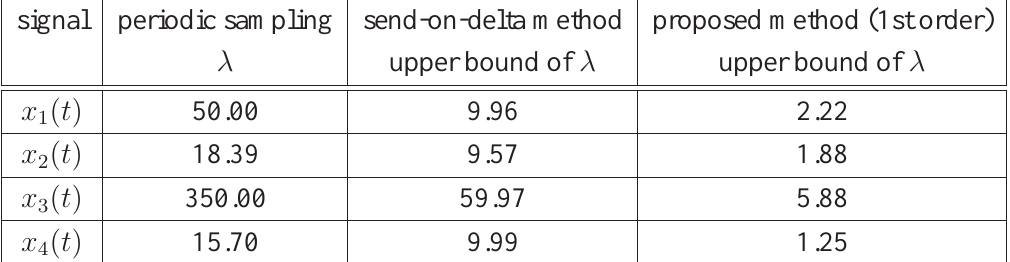
Table 3 . mean rate of messages ( λ ) comparison with δ = 0 .